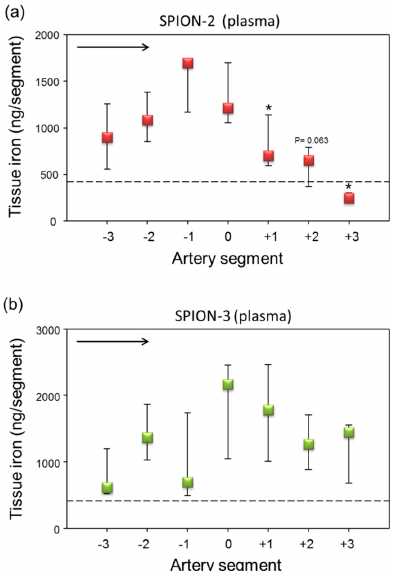
Figure 1. Magnetic targeting of circulating superparamagnetic iron oxide nanoparticles (SPION)-2 and SPION-3 suspended in plasma. ( a ) SPION-2 and ( b ) SPION-3 suspensions at 30 µ g Fe / mL were circulated in the model for 30 min under external magnetic force positioned at segment 0. Arrow indicates the direction of flow. Shown is iron concentration of respective segments (median with 75th and 25th percentile of n = 5 experiments). Average control values (SPIONs suspensions without magnet) are indicated by dashed line. * P < 0.05 versus segment 0; trend P values are indicated. Molecules 2019 , 24 , x FOR PEER REVIEW When particles were suspended in freshly isolated citrated human blood, an overall strong increase in iron content along the artery wall was measured, which may be related to partial